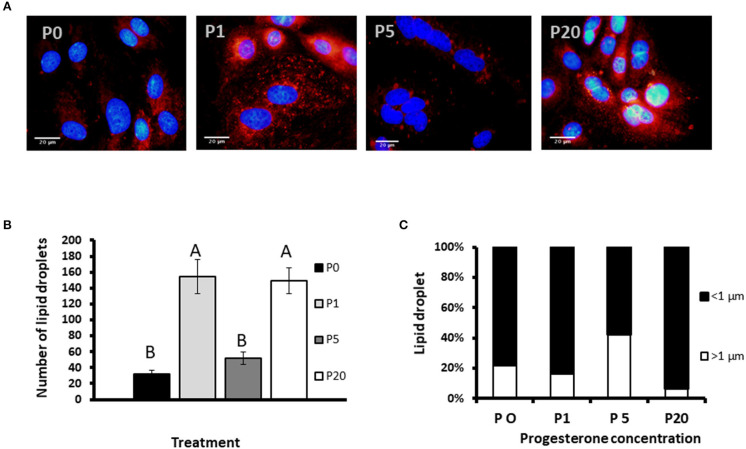
The effect of progesterone on morphometric traits of intracellular lipid droplets in mammary epithelial cells (MECs). MECs were treated with progesterone at 0, 1, 5, and 20 ng/ml (P0, P1, P5, and P20, respectively) for 24 h. After incubation, nucleus was stained with DAPI (blue) and lipid droplets with Nile red (red). Cells were visualized under fluorescence microscope. The number and size of lipid droplets were recorded. (A) Representative pictures of MECs and lipid droplets treated with different progesterone concentrations. Scale bars, 20 μm. (B) Number of lipid droplets per treatment. Data presented as mean ± SEM and different letters indicate differences between treatment groups at significant levels of p ≤ 0.0001. (C) Distribution of lipid droplet size. Lipid droplets were divided to size categories; small: x < 1 μm (black), large: x > 1 μm (white). Nine representative fields (10 to 30 cells per field) were analyzed for each replicate (n = 3 replicates per treatment). Differences between treatments were determined by χ2-test (p ≤ 0.05).